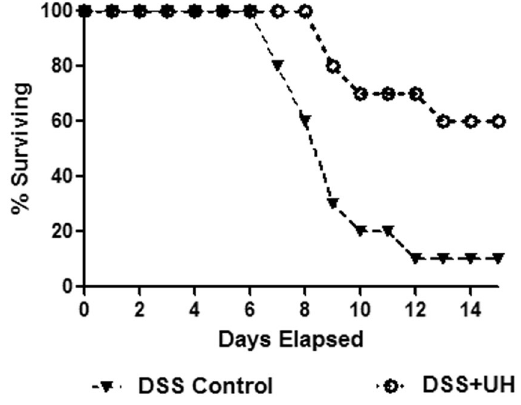
Figure 2. Survival study. Comparison of survival rate was done with mice challenged with 4% of DSS and DSS + Uridine 10 mg/kg. Percentage survival data of n = 10 animals.